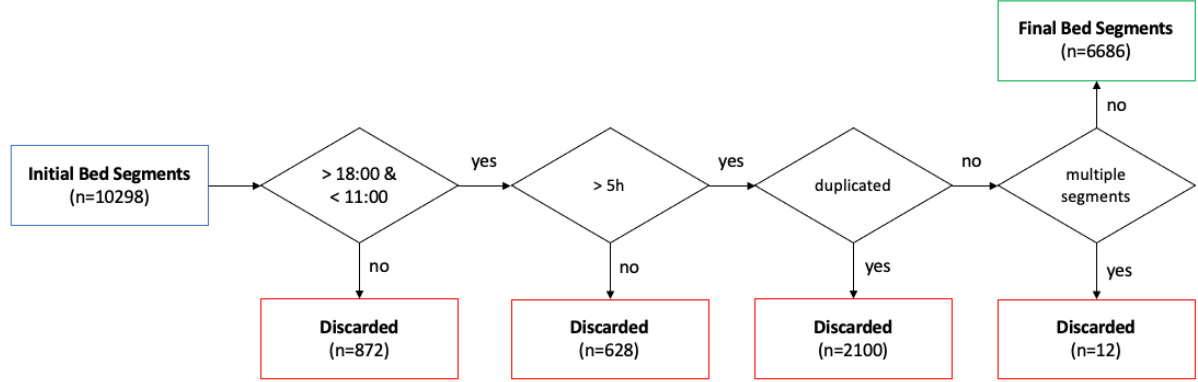
Figure 1. Preprocessing